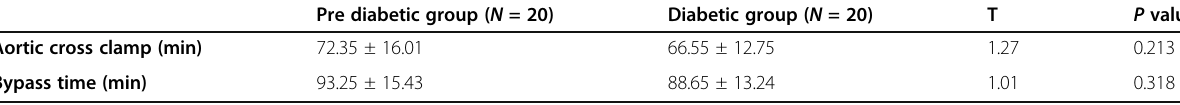
Table 3 Comparison between the two studied groups according to intraoperative events Pre diabetic group ( N = 20)